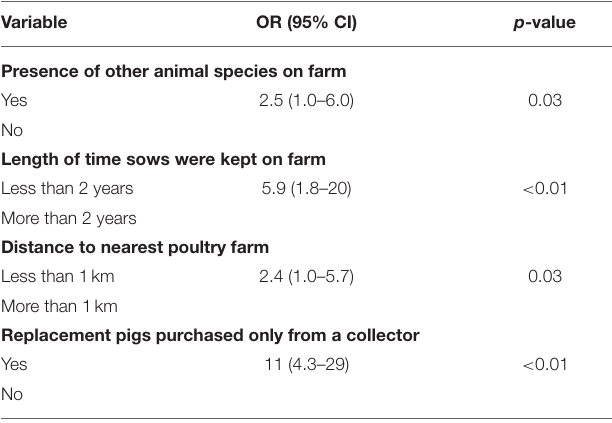
TABLE 1 | Herd-level risk factors H1N1 swine influenza seropositivity, West Java and Banten provinces, Indonesia, 2016–2017, from multivariable logistic regression